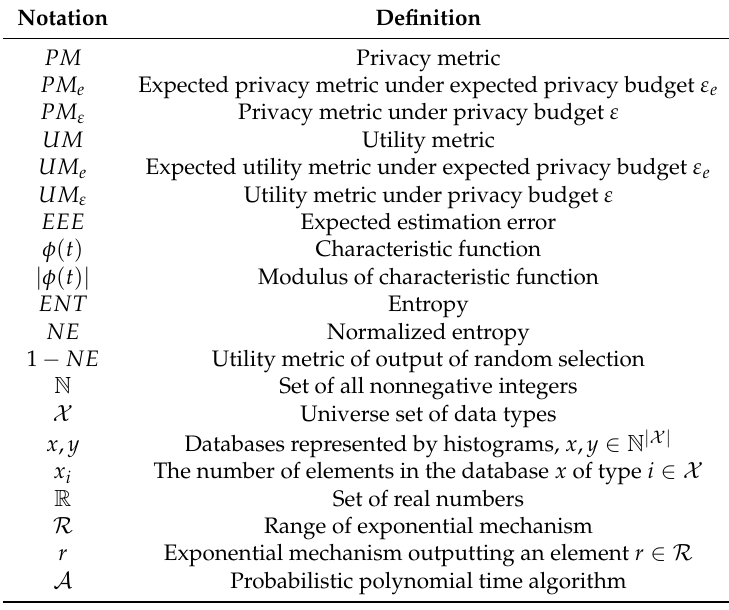
Table 1. Definition of